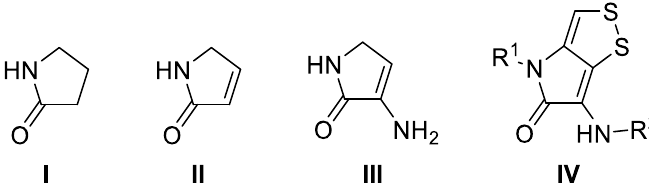
Figure Figure 1. General structure of γ -lactams I , 1,5-dihydro-2 H -pyrrol-2-ones II , 3-amino 1,5-dihydro-2 H - pyrrol-2-ones II , and dithiopyrrolone antibiotics IV .